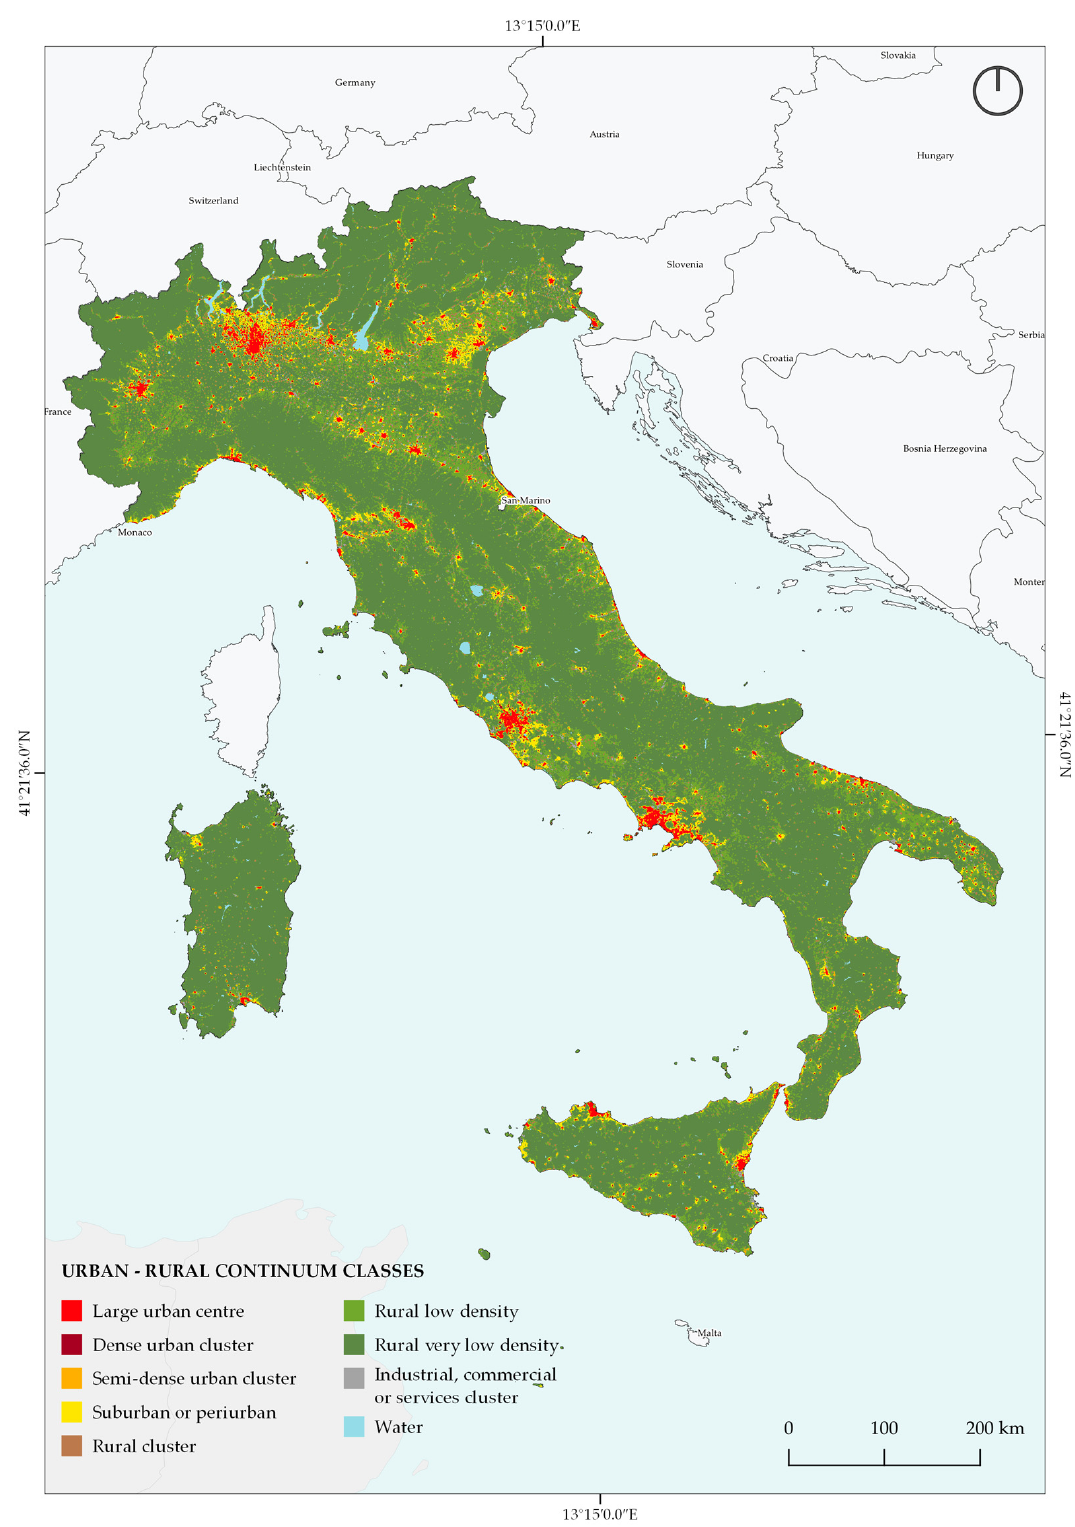
Figure 5. Urban–rural continuum in Italy (2018). The map shows the location and spatial configuration of the urban clusters and the extension of the related expansion areas. Here, the rural spaces close to the dense urban cores have undergone a conversion into urban uses with a tendency to connect with each other.